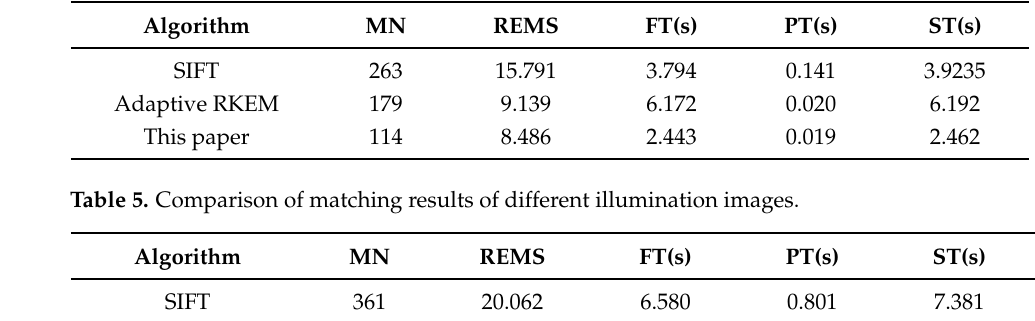
Table 4. Comparison of matching results of images of different scales images.